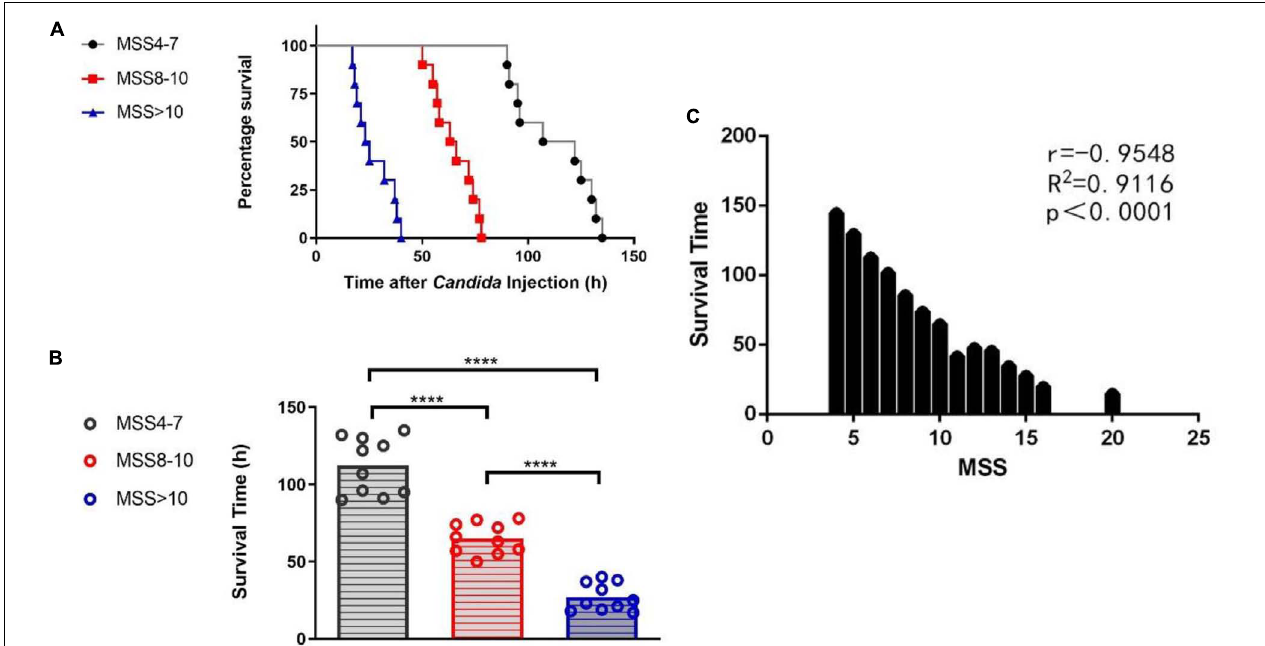
FIGURE 2 | Group difference and correlation between Murine Sepsis Score (MSS) and survival time of mice. Survival rates between MSS 4-7, MSS 8-10 and MSS > 10 mice (A) . Mice in different MSS group had varied survival time (B) . Correlation between MSS and survival time (C) . Survival rates were observed for every 1 h after Candida injection. P -value between any two of the three different curves of MSS groups analyzed by log-rank test was < 0.0001. MSS was assessed at 12 h after Candida injection. Mean ± SD, 10 mice per group. **** P < 0.0001.